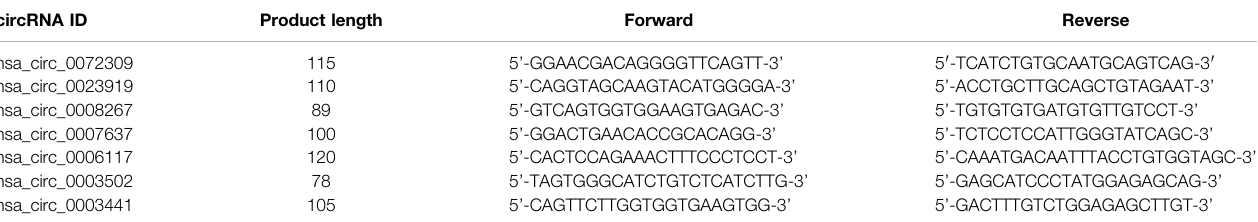
TABLE 1 | Sequences of PCR primers.